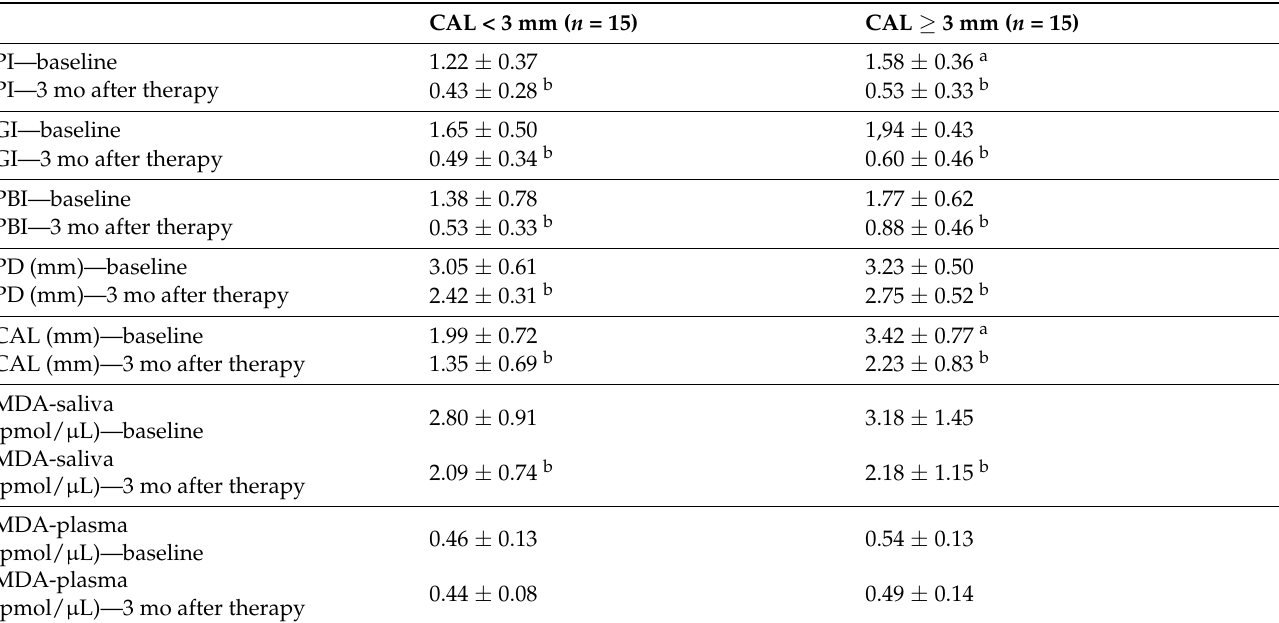
Table 5. Periodontal indices and MDA levels at baseline and three months upon therapy completion in groups with CAL < 3 mm and CAL ≥ 3